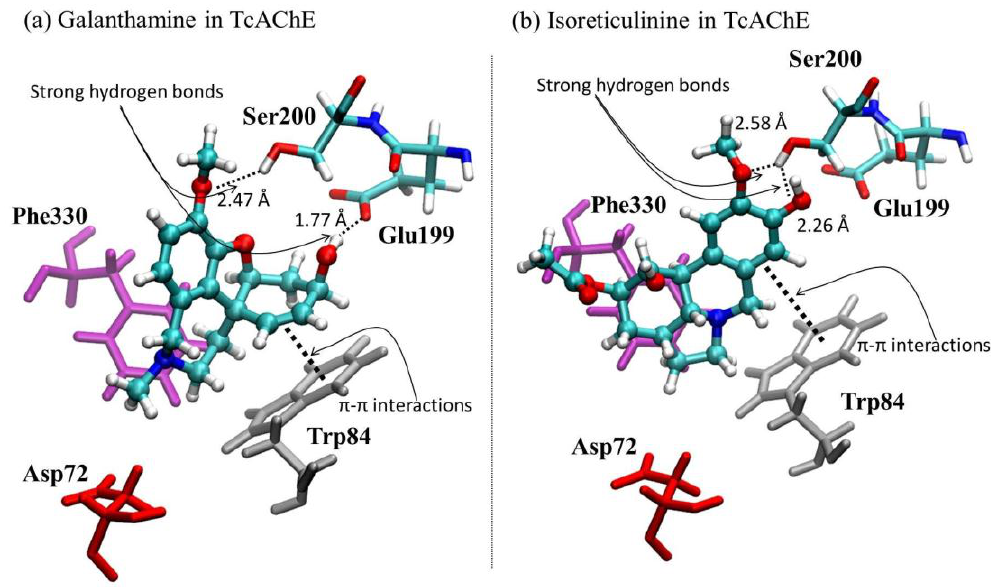
Figure 5. Graphical representations of ( a ) galanthamine- Tc AChE and ( b ) isoreticulinine -Tc AChE complexes.